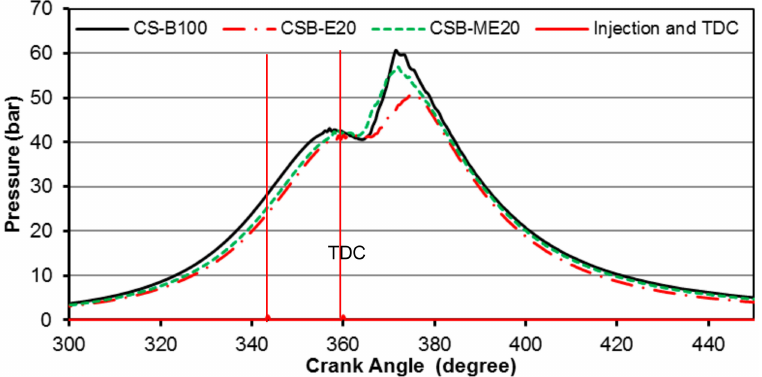
Figure 3. In-cylinder pressure at an engine speed of 3670